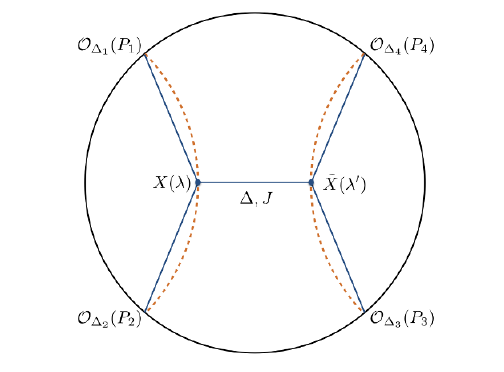
Figure 1 . Four point scalar geodesic Witten diagram where the orange curves describe the geodesics and the blue lines are bulk to boundary propagators, such that the interaction vertices move along geodesics (cid:13) 12 and (cid:13) 34